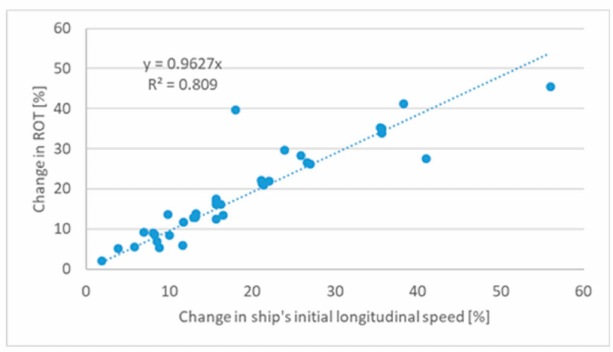
Figure 3. The change in ROT that results from the longitudinal speed change